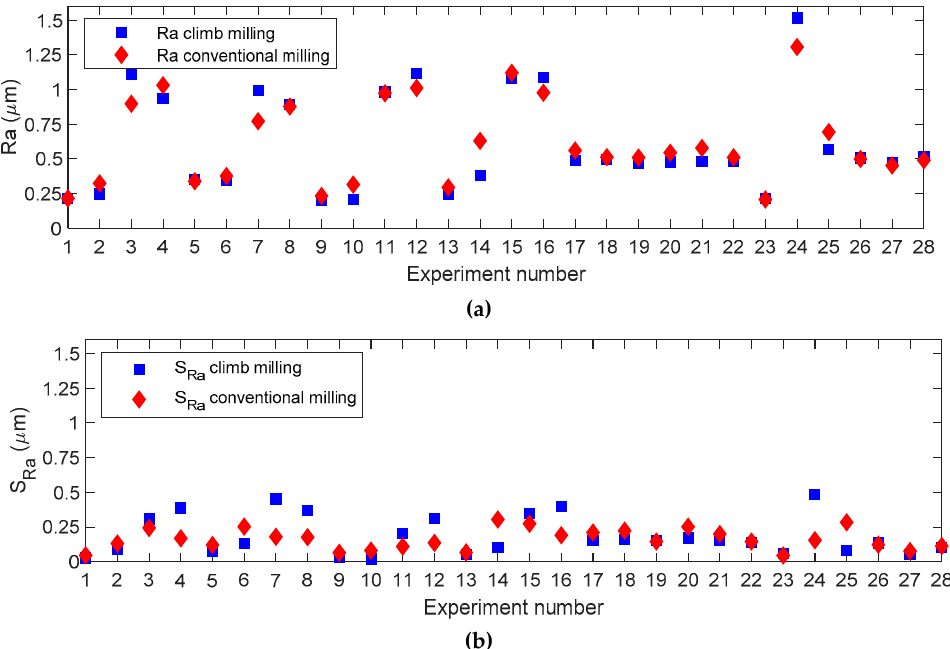
Figure 8. Experimental deviation plots for Ra considering both manufacturing strategies: ( a ) Mean, ( b ) standard deviation.